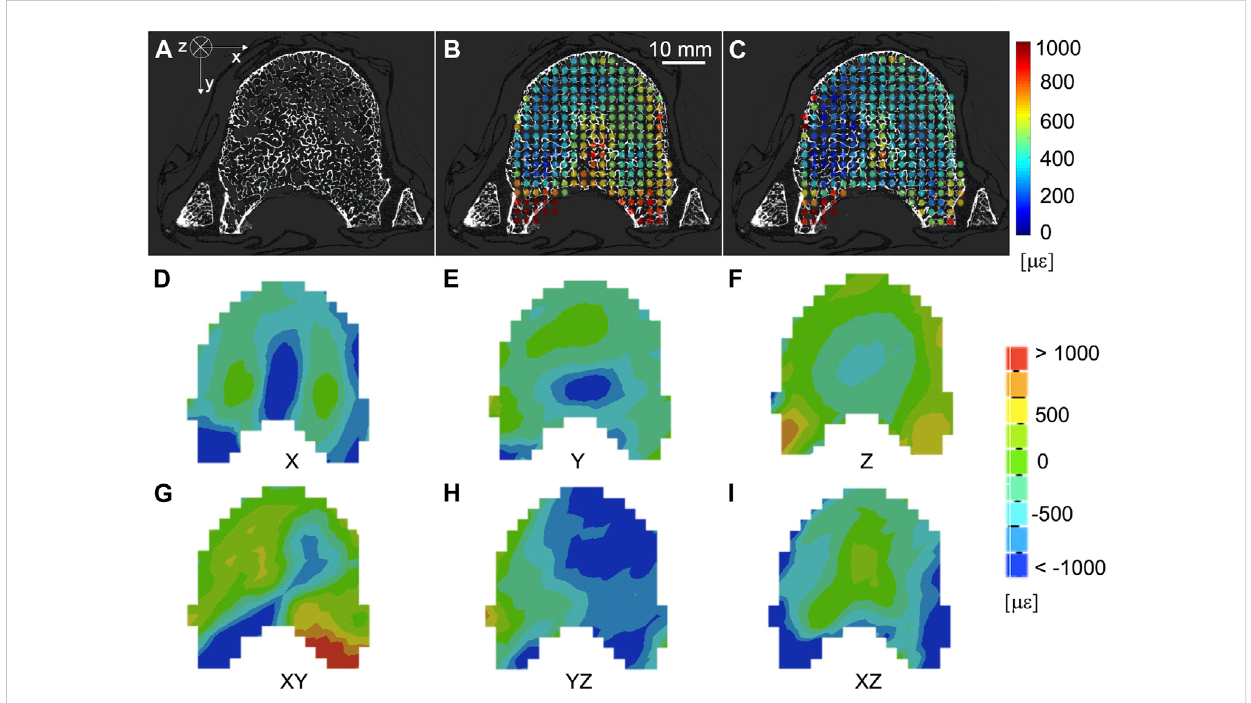
FIGURE 6 (A) microCT cross section of a healthy vertebra. Spatial distribution of the mean (B) and standard deviation (C) of the absolute value of the six components of thestrain [ μ ε ] (NS = 50 voxels) on thesame microCTcross section. From (D – I) spatial distributionof the six components of thestrain [ μ ε ] (NS = 50 voxels) on the same microCT cross